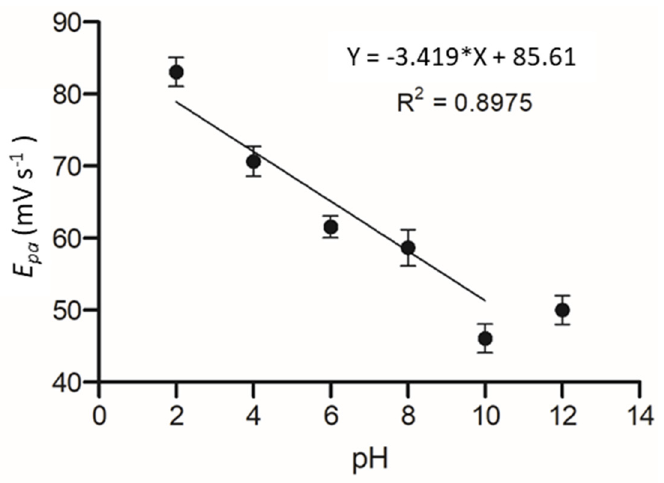
Figure 8. Plot of E pa vs. pH at a range of 2 to 12 in Britton–Robinson buffered KCL solution.